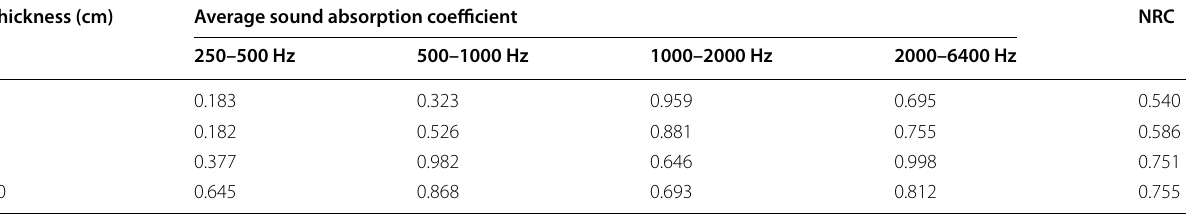
Table 1 The average sound absorption coefficient at four frequency sections and NRCs of pine cone particle sound absorbers Thickness